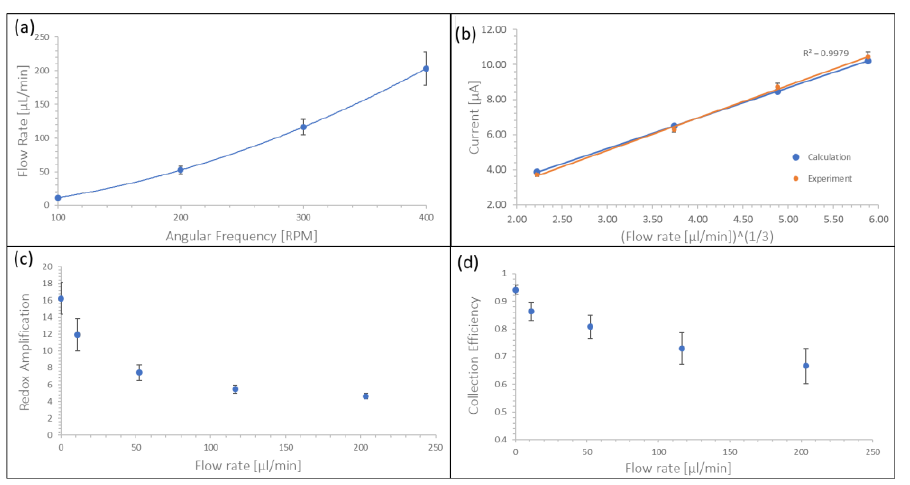
Table 2. Single versus dual mode sensitivities and LOD for platinum IDA under flow. Test Condition